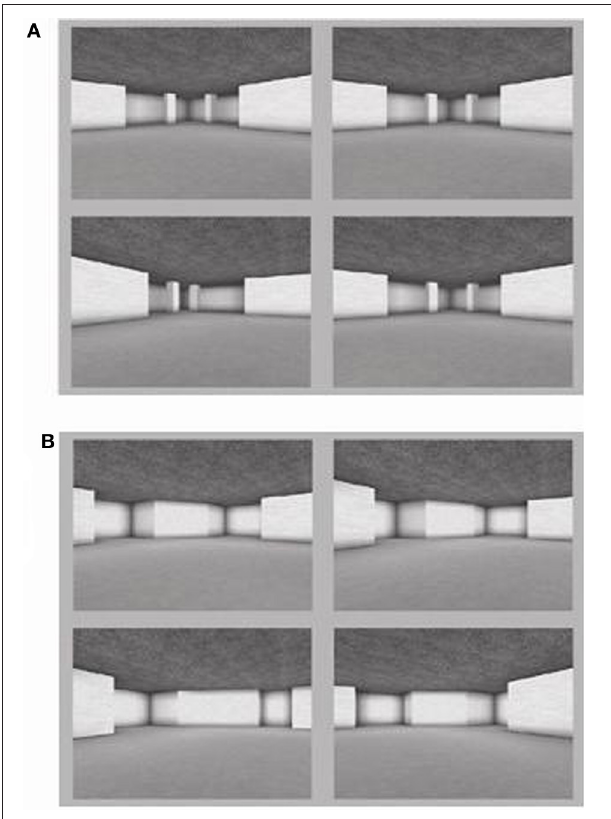
FIGURE 5 | Scene stimuli used by Lee and colleagues (2005a) to assess whether amnesic patients were impaired at visual discrimination of scenes. Adapted with permission from Lee et al. (2005). Copyright ©2005 Wiley-Liss